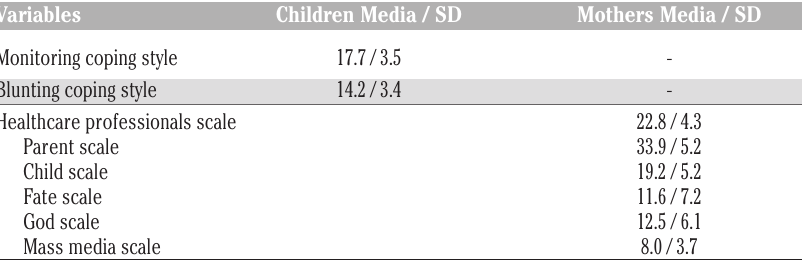
Table 2. Descriptive Statistics (children N= 60; mothers N=